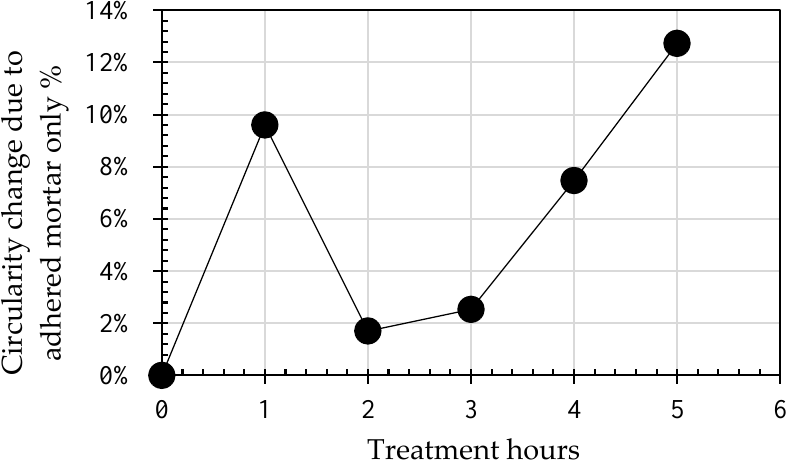
Figure 6. Effect of treatment hours on the difference between circularity changes of RCA and NA 8/20 mm.